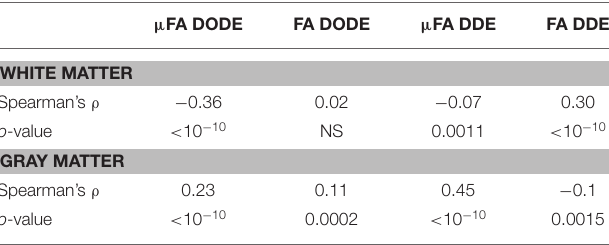
TABLE 2 | Statistical analysis of correlations between ( µ )FA and myelin water fraction in white matter and gray matter. µ FA DODE FA DODE µ FA DDE FA DDE WHITE MATTER Spearman’s ρ − 0.36